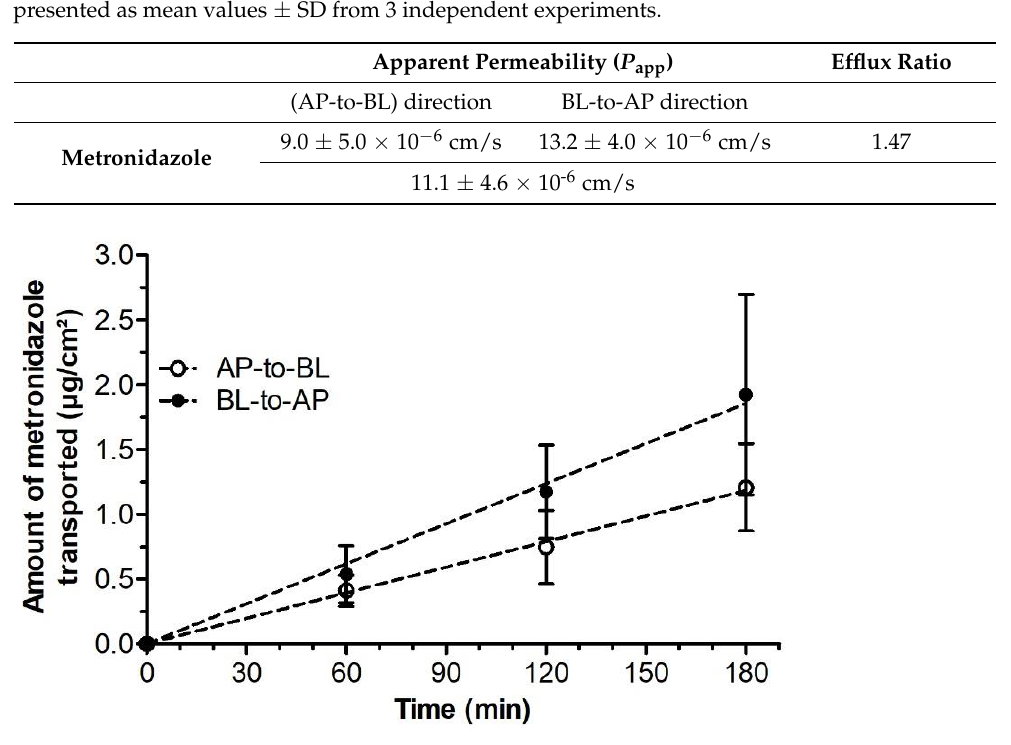
Figure A1. Amounts of metronidazole transported across Caco-2 monolayers over time. Results are presented as mean values ± SD from 3 independent experiments.